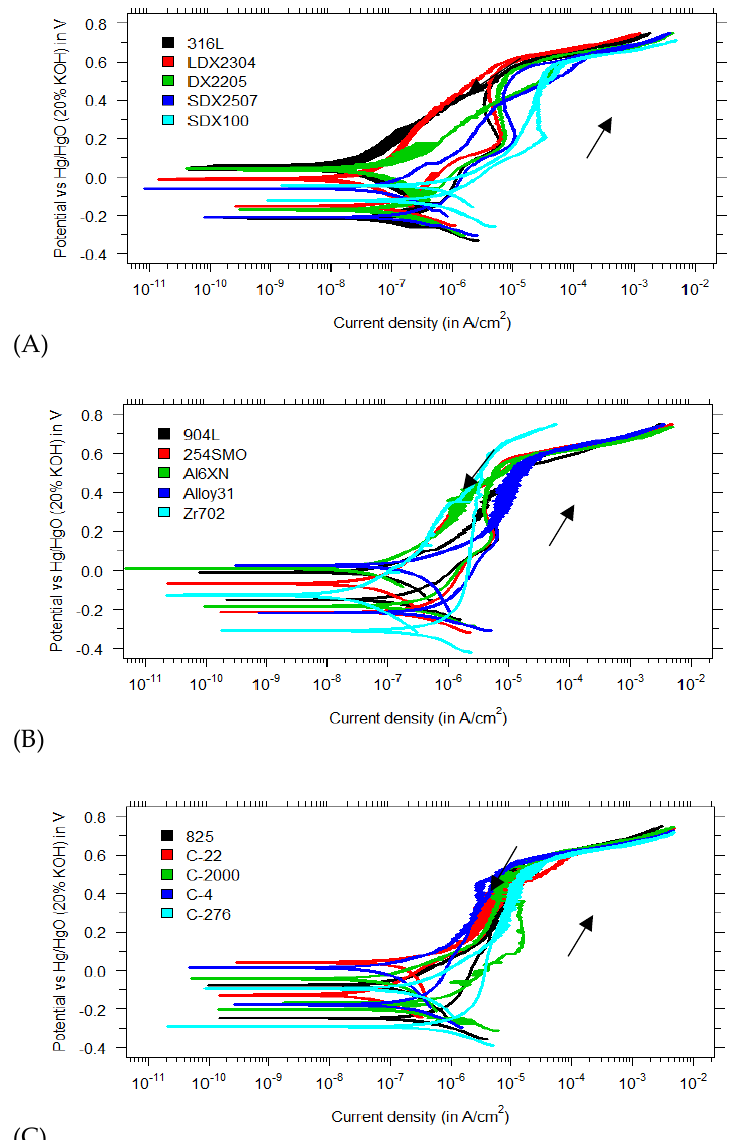
Figure 4. Polarization curves in a KOH/NaOH mixture (pH 13.5) with 1 M Cl − for ( A ) regular, duplex and super duplex stainless steels; ( B ) superaustenitics and zirconium-based alloys; and ( C ) nickel − based alloys.